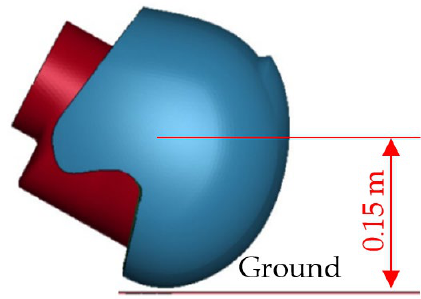
Figure 9. FE model for the sliding case.